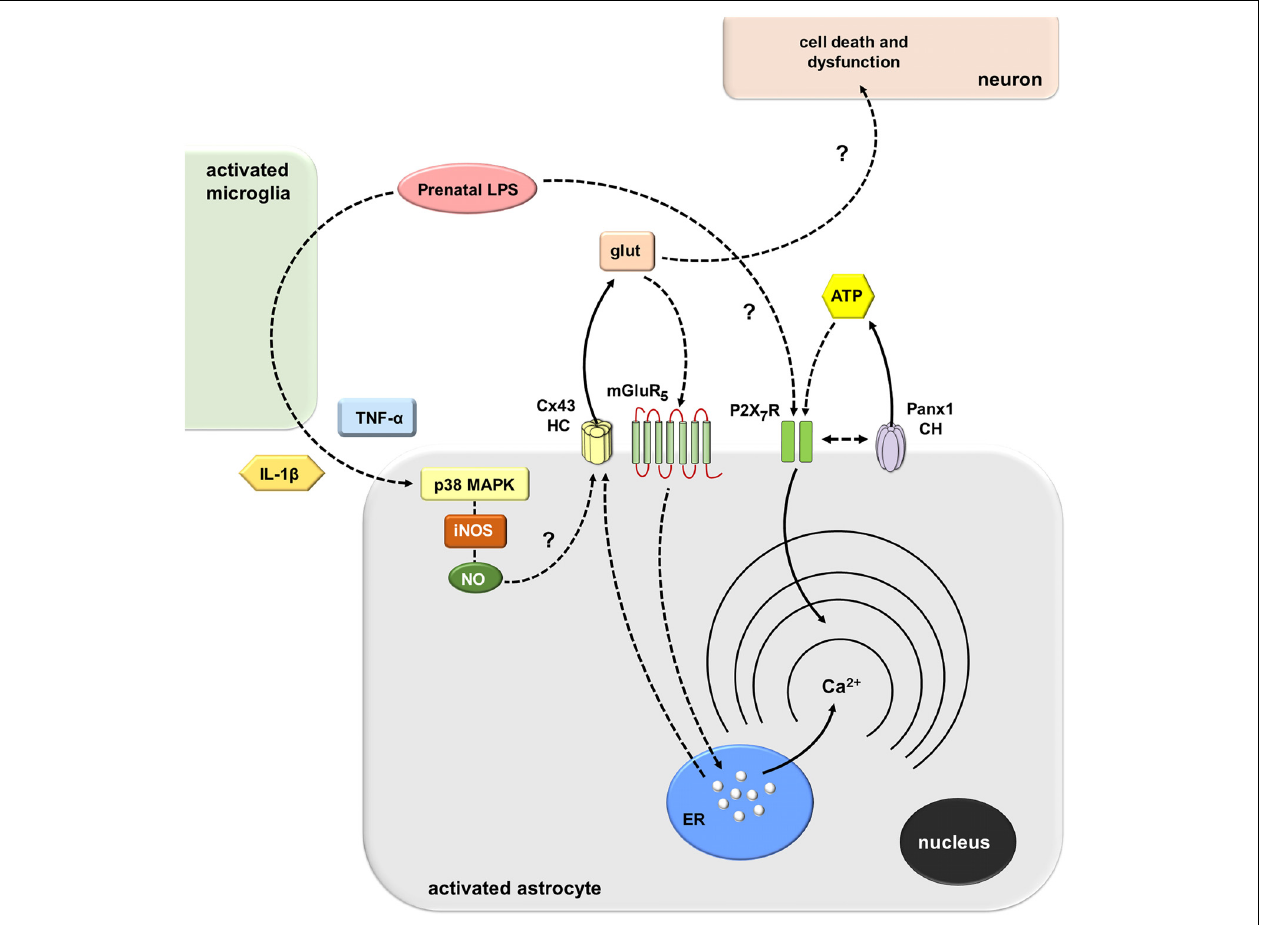
FIGURE 9 | Schematic diagram showing the possible pathways involved in the prenatal LPS-induced activation of Cx43 hemichannels/Panx1 channels and its consequences for astroglial function and neuronal survival. Prenatal LPS exposure activates microglia, resulting in the release of IL-1 β and TNF- α . Both cytokines stimulate astrocytes, leading to the activation of a p38MAPK/iNOS-dependent pathway and further production of NO. The latter likely induces unknown mechanisms that cause opening of Cx43 hemichannels enabling the release of glutamate. Glutamate released via Cx43 hemichannels activates mGluR 5 receptors resulting in the stimulation of IP 3 receptors and further release of Ca 2 + stored in the endoplasmic reticulum. In parallel, the activation of astroglial P2X 7 receptors lead to the opening of Panx1 channels and further release of ATP, possibly through direct protein-to-protein interactions. Relevantly, the modulation of [Ca 2 + ] i dynamics evoked by Cx43 hemichannels may alter astroglial morphology (not depicted), whereas the excitotoxic release of glutamate through Cx43 hemichannels may affect neuronal arborization and survival by unknown